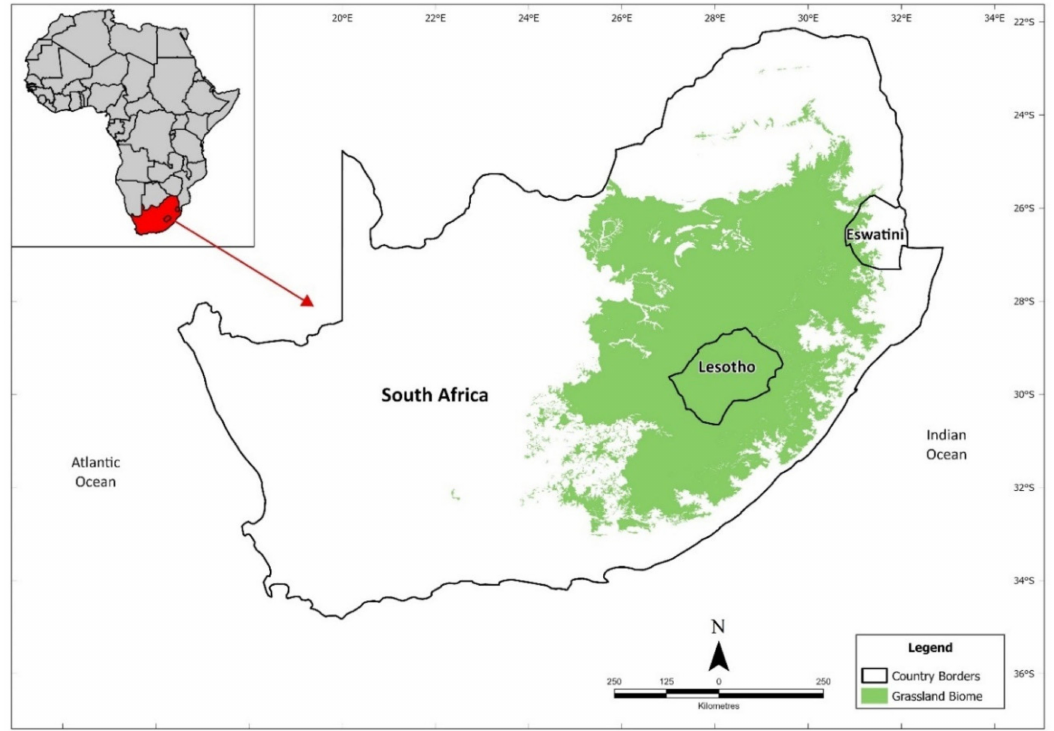
Figure 2. Extent of the Grassland Biome in South Africa, Lesotho and Eswatini. Grassland cov- erage is derived from the National Vegetation Map, South African National Biodiversity Institute (2006–2018), The Vegetation Map of South Africa, Lesotho and Eswatini; Mucina, L., Rutherford, M.C., Powrie, L.W., Eds.; online: http://bgis.sanbi.org/SpatialDataset/Detail/18; version 2018 (accessed on 22 February